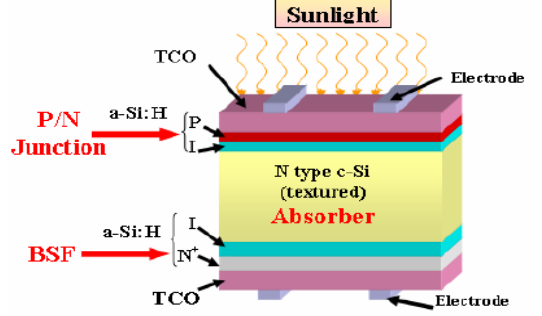
Fig. 2. Photovoltaic Cell